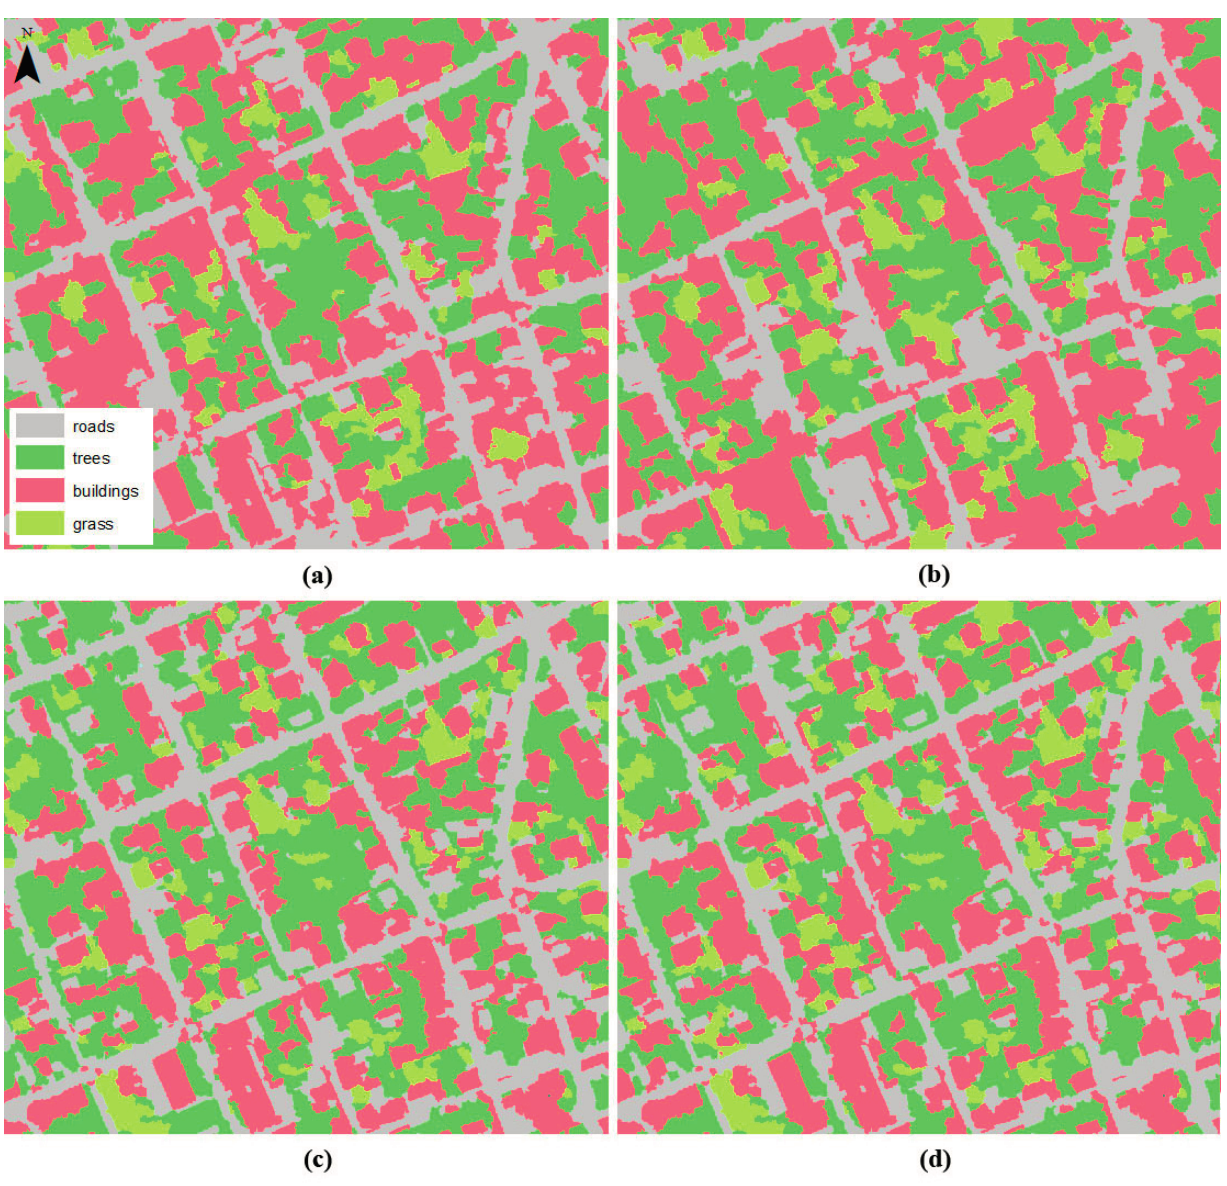
Figure 10. The final classification image for all four classifiers related to the 8-band classification results presented in Table 4: ( a ) k -NN; ( b ) SVM; ( c ) the